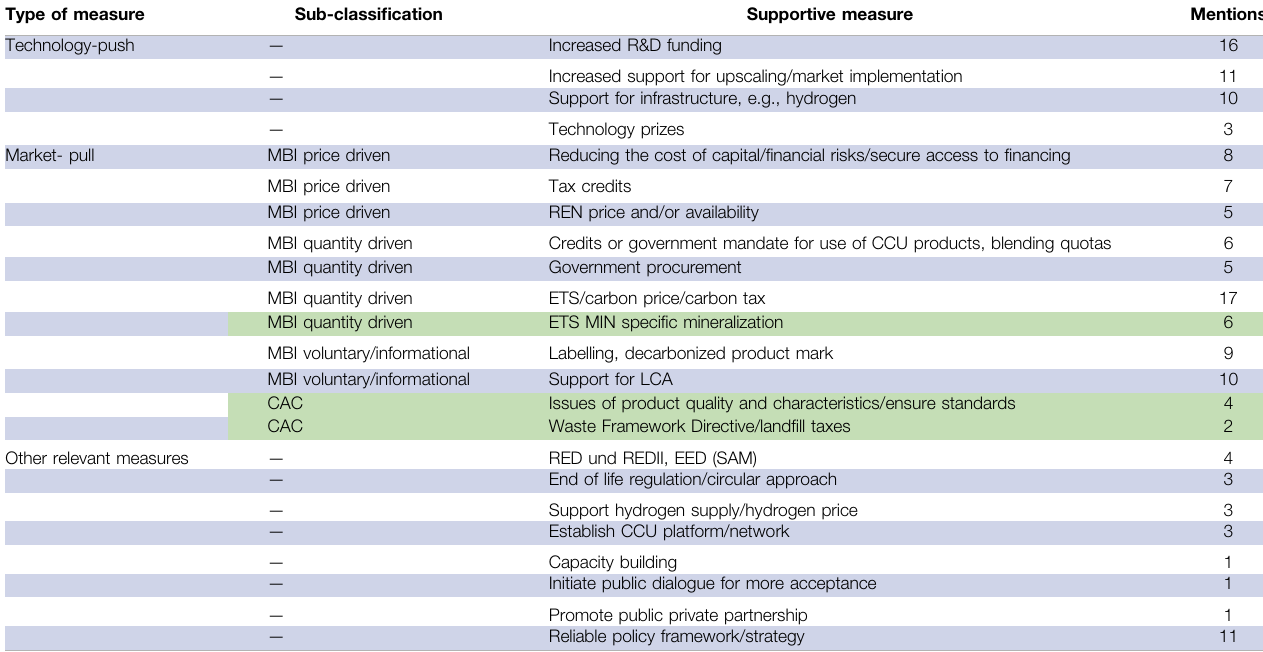
TABLE 1 | Overview of policy measures in the analyzed reports. Green background: Policy measures that apply only to CO 2 -mineralization. Type of